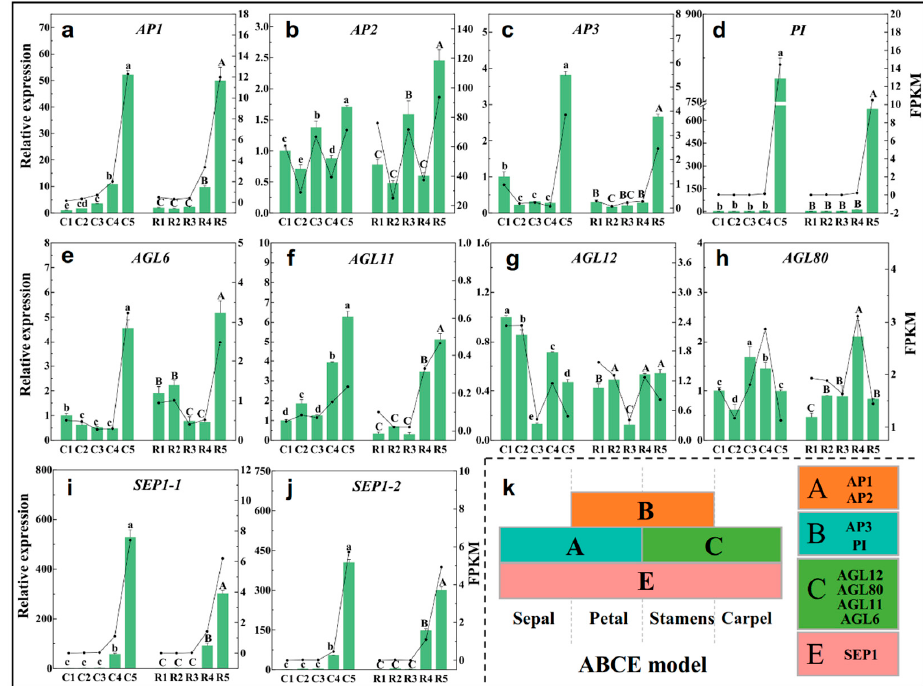
Figure 8. Expression of ABCE model genes at different differentiation stages in two cultivation patterns, AP1 ( a ), AP2 ( b ), AP3 ( c ), PI ( d ), AGL6 ( e ), AGL11 ( f ), AGL12 ( g ), AGL80 ( h ), SEP1-1 ( i ), SEP1-2 ( j ), ABCE model ( k ). The histogram and left axis are the relative expressions measured by RT-qPCR, and the dot-line and right axis are the FPKM value obtained by RNA-Seq. C1–C5 represent the five stages of shelter-free cultivation, R1–R5 represent the five stages of rain-sheltered cultivation. Error bars show the Mean ± SD of the three biological replicates. Different capital letters on the bars indicate significant differences between different stages of rain-sheltered model at p < 0.05 determined by Duncan’s tests, lowercase letters indicate significant differences of shelter-free model.